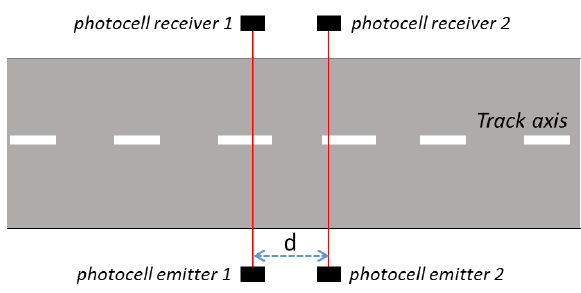
Figure 1. A schematic of the two couple of photocells positioned on the track.